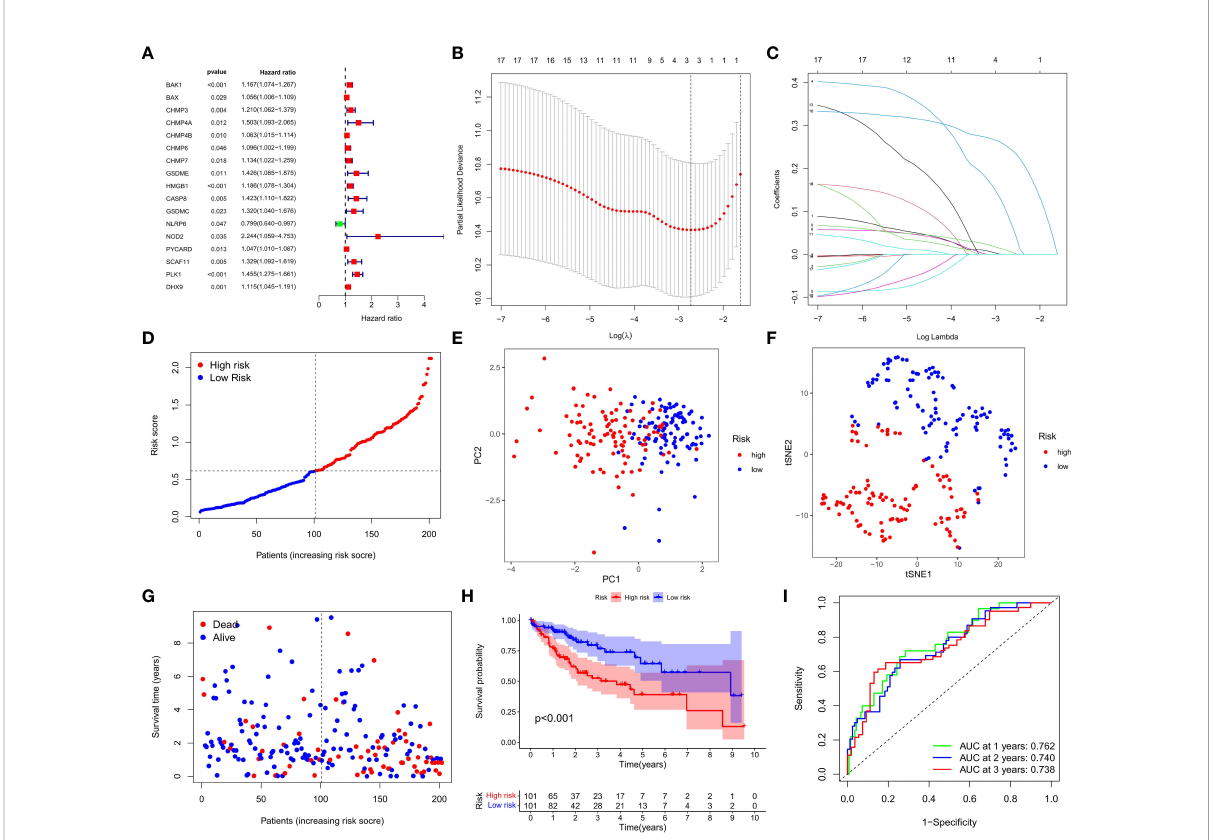
FIGURE 3 Construction of the DEGs prognostic model. (A) Univariate Cox regression analysis was used to assess DEGs of 202 HCC samples in the training cohort, and 17 genes were screened out upon P<0.05. (B) Cross validation of the 17 genes was performed for tuning the parameter selection in the LASSO regression. (C) 17 genes were assessed in LASSO Cox regression for the construction of a prognostic model. (D) Patients in training cohort were arrayed based on the risk score. (E) PCA for survival status was plotted based on the risk score. (F) T-SNE for survival status was plotted based on the risk score. (G) The survival status of patients was shown in the high- and low-risk population. (H) Kaplan-Meier survival curves of patients were displayed in high- and low-risk groups. (I) ROC curve was used to evaluate the predictive ef fi cacy of the prognostic